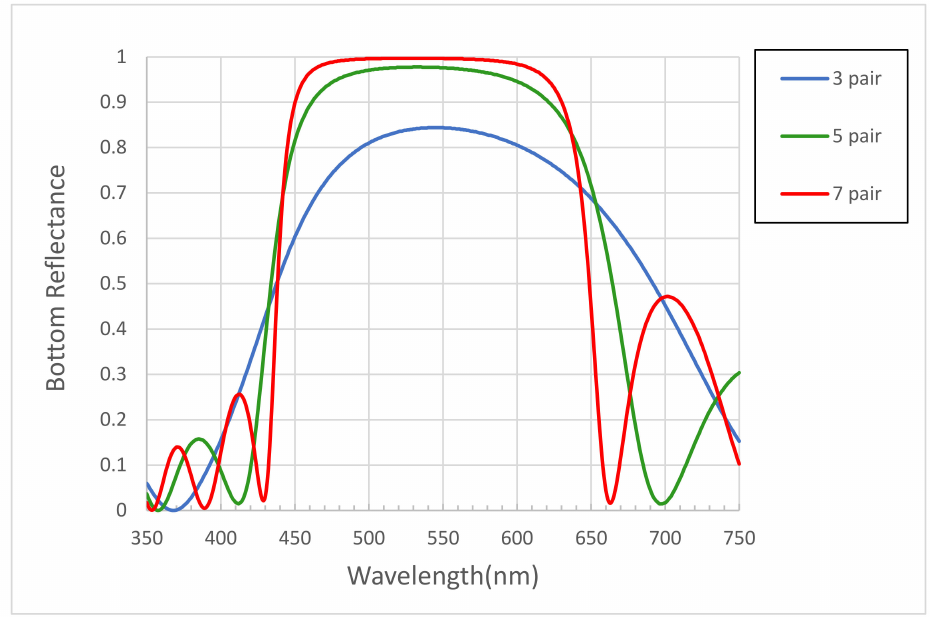
Figure 11. Calculated bottom reflection spectra of the device fabricated by Kitabayashi et al.